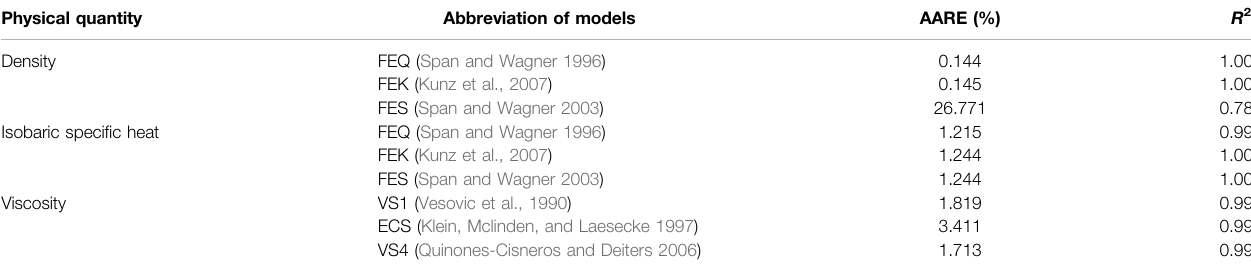
TABLE 2 | Comparison between the predicted and experimental data out of pseudocritical region. Physical quantity Abbreviation of models